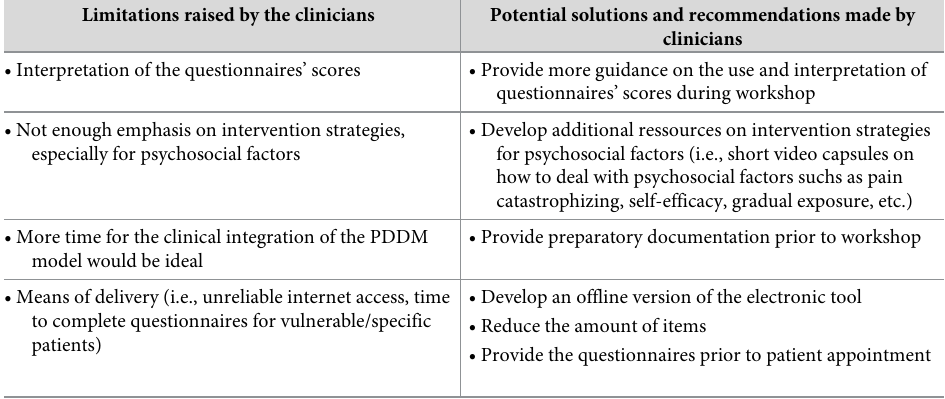
Table 5. Limitations and recommendations reported by the